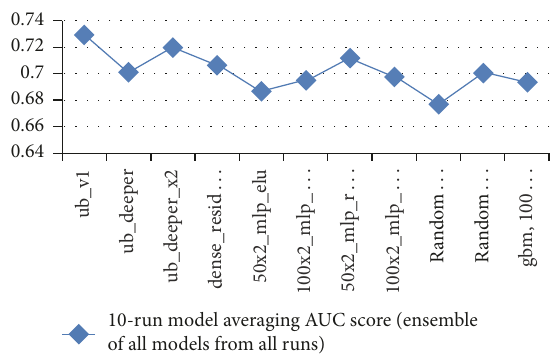
runs)0.640.660.680.70.720.74 10-run model averaging AUC score (ensemble of all models from all Figure 6: AUC scores of various models (averaged over 10 runs). AUC plot for dataset 1 Figure 7: ROC curve for dataset 1. AUC plot for dataset 2 Figure 8: ROC curve for dataset 2.